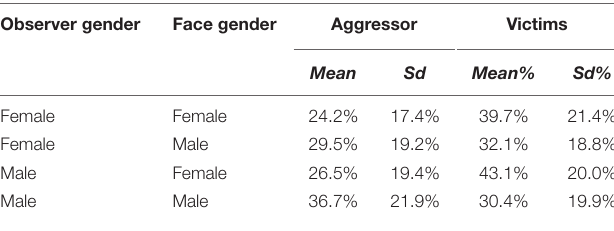
TABLE 1 | Average percentage of male and female faces perceived as having been aggressors and victims by male and female